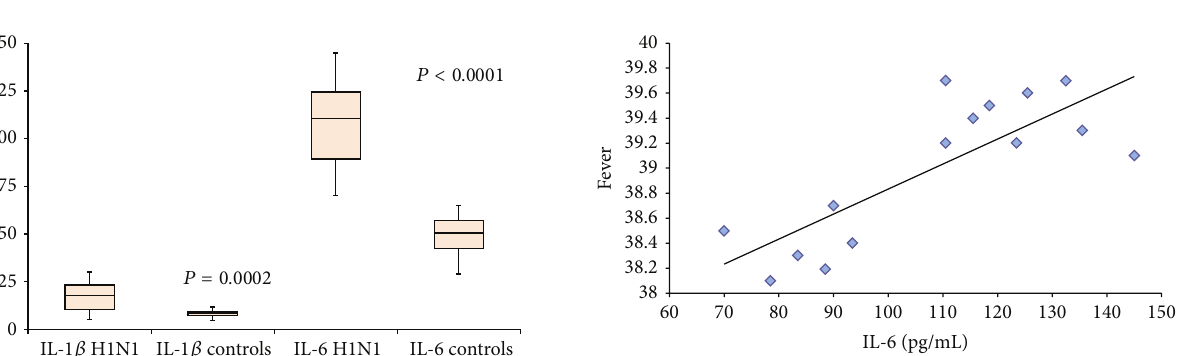
Figure 5: A scatter plot shows the relationship between fever and IL-6 plasma levels. The line represents the regression line (linear regression equation: fever = 0.02 × IL-6 + 36.8 𝑅 2 = 0.64 ).